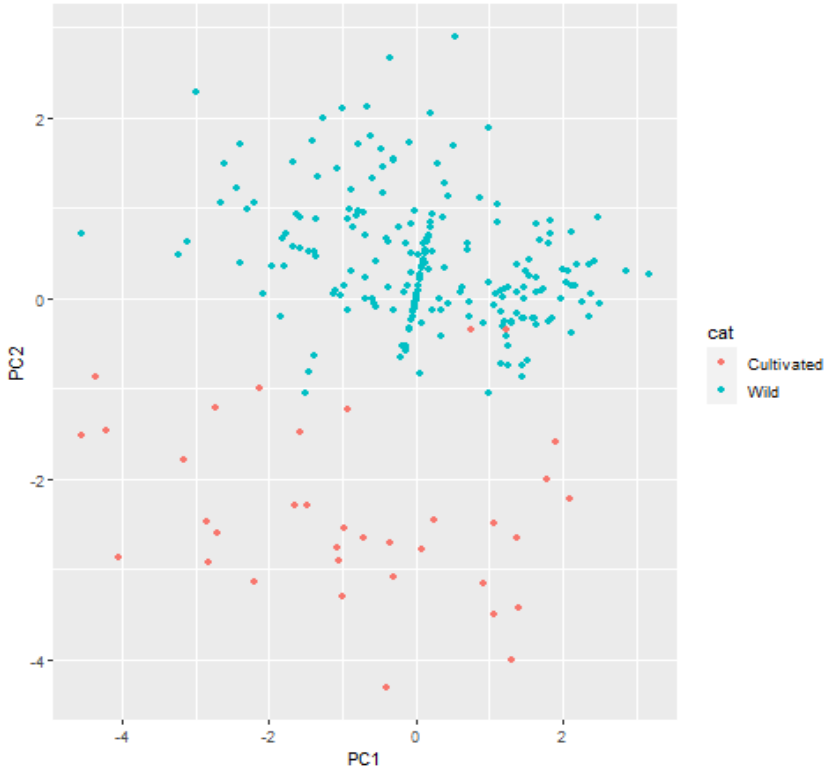
Figure 1. Density distribution for comparison of Hordeum spontaneum bulked seed accessions with elite germplasm and cultivars of cultivated barley for β -glucan and microelements contents.